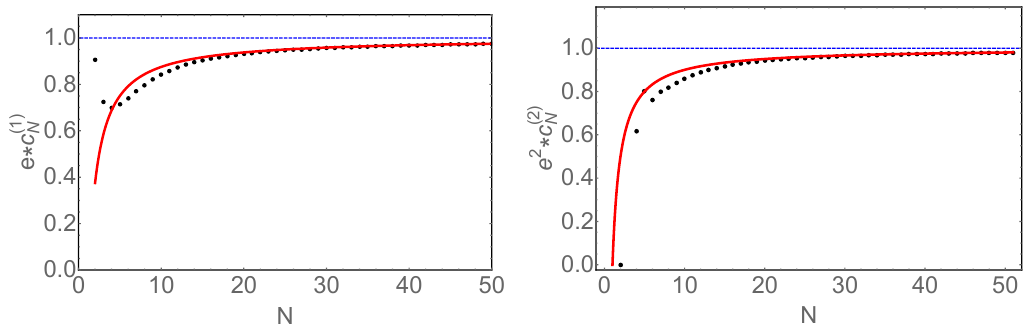
Figure 13: Asymptotic of the skeleton Feynman diagrams number for the self-energy for d = 1 KM model, red solid line is 1 − 5 / ( 4 n ) (left) and d = 2 KM model, red solid line is 1 − 1 / n